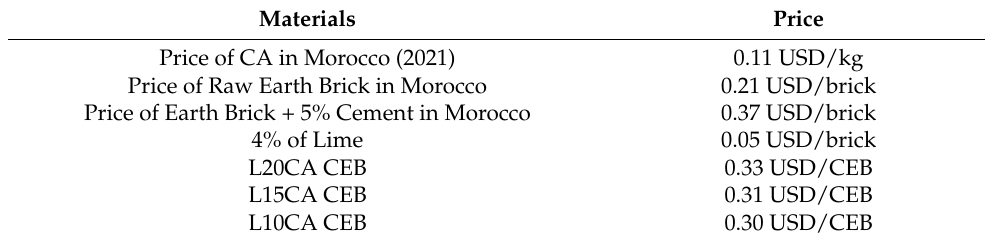
Table 5. CEB Cost of